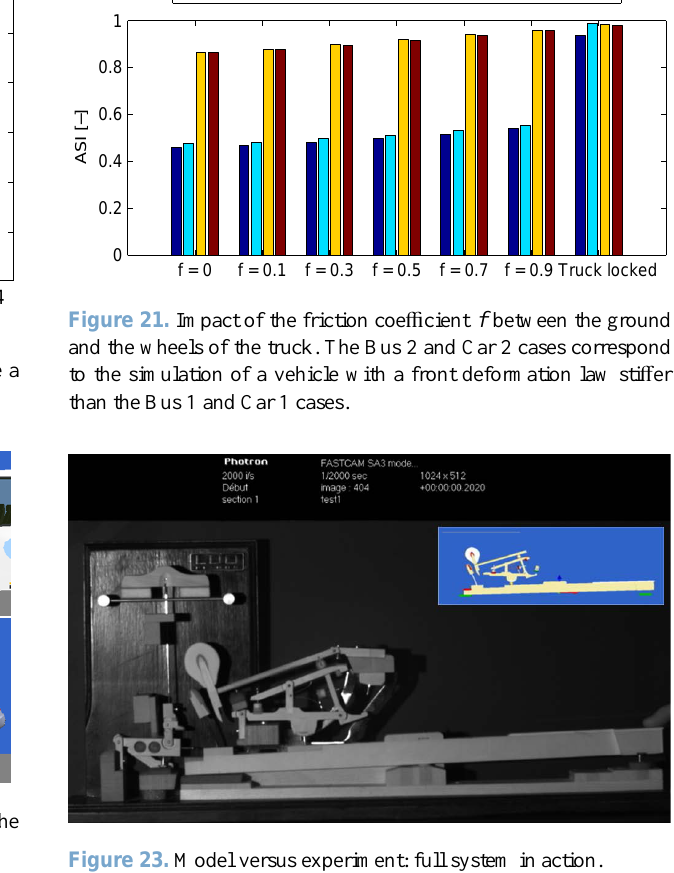
Figure 23. Model versus experiment: full system in